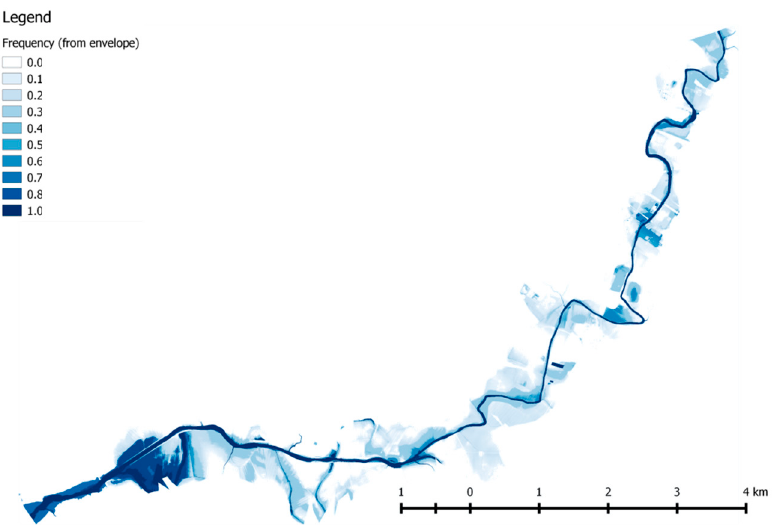
Figure 6. Flood map envelope. The frequency of each cell to be flooded is presented in color ranging from white (i.e., 0) to dark blue (i.e., 1).